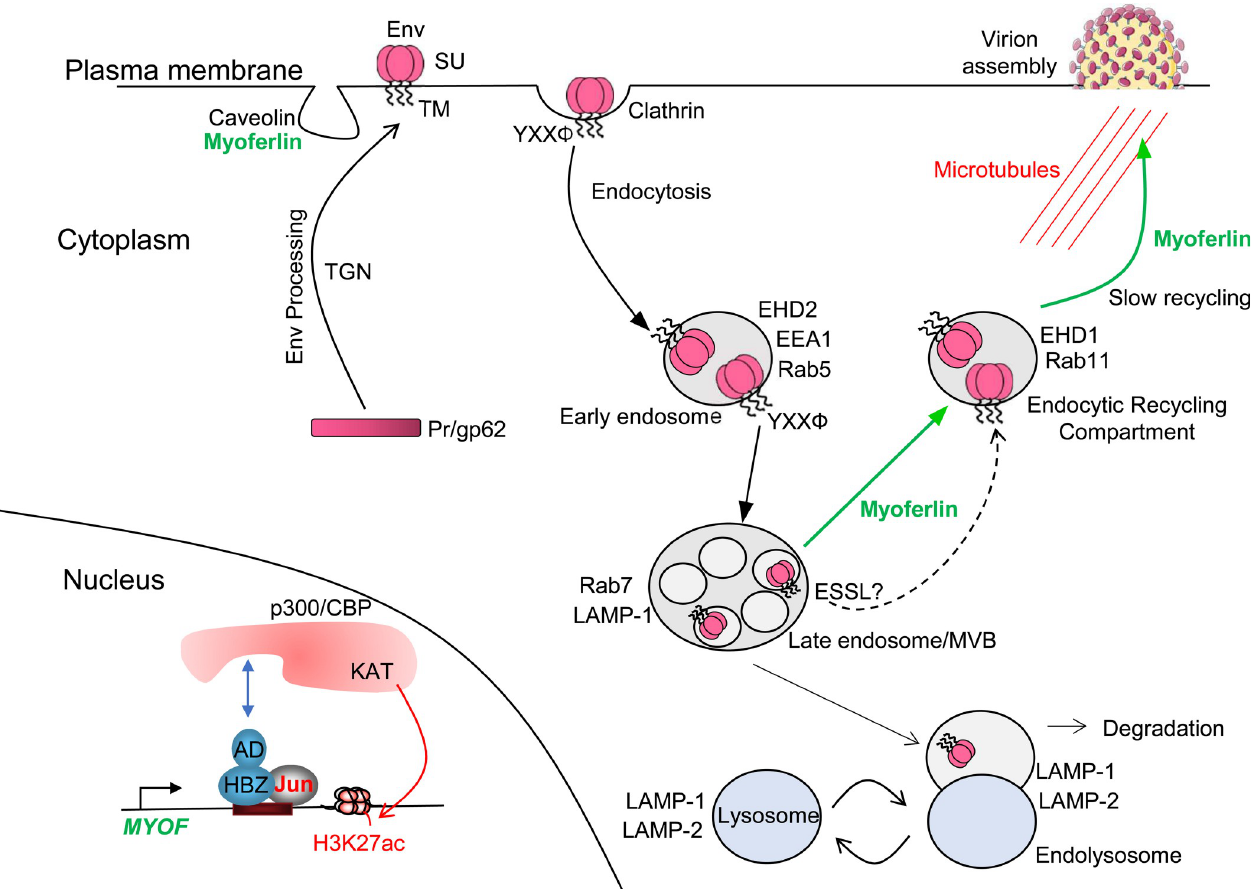
Fig 10. Proposed model of MyoF-mediated Env trafficking in HTLV-1-infected T-cells. Through its activation domain (AD), HBZ recruits p300/CBP to the MYOF gene enhancers to activate transcription. Env is processed to its mature form through the Trans-Golgi Network (TGN) and incorporated into the plasma membrane. The YXX F motif in Env mediates clathrin-dependent endocytosis and trafficking of Env to lysosomes. However, the presence of MyoF causes Env to be redirected to the endosomal recycling compartment from which Env traffics to sites of virion assembly. Apart from MyoF the ESSL domain separately reduces lysosomal-mediated degradation of Env. One component of this figure was drawn using a picture from Servier Medical Art, which